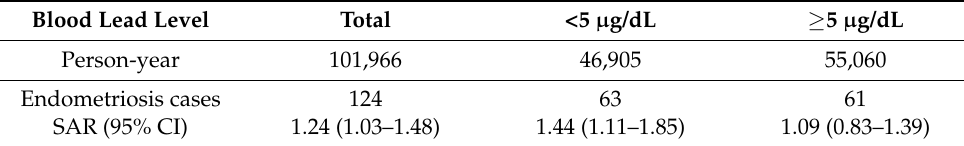
Table 2. The SARs of EM by BLLS (<5 µ g/dL, ≥ 5 µ g/dL) in Lead exposed workers when compared with general population.